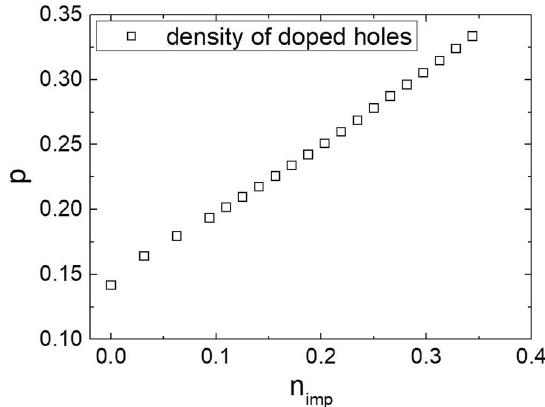
Fig. 2 Plot of the density of doped holes as a function of impurity concentration. The disorder strength is fi xed with w =